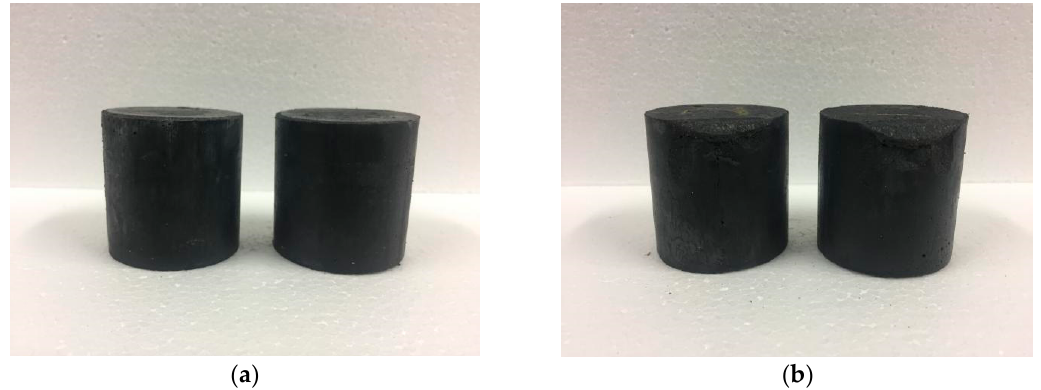
Figure 11. M–S–H cement-solidified body with 0.8 wt % Cs + before ( a ) and after ( b ) anti-shock testing.